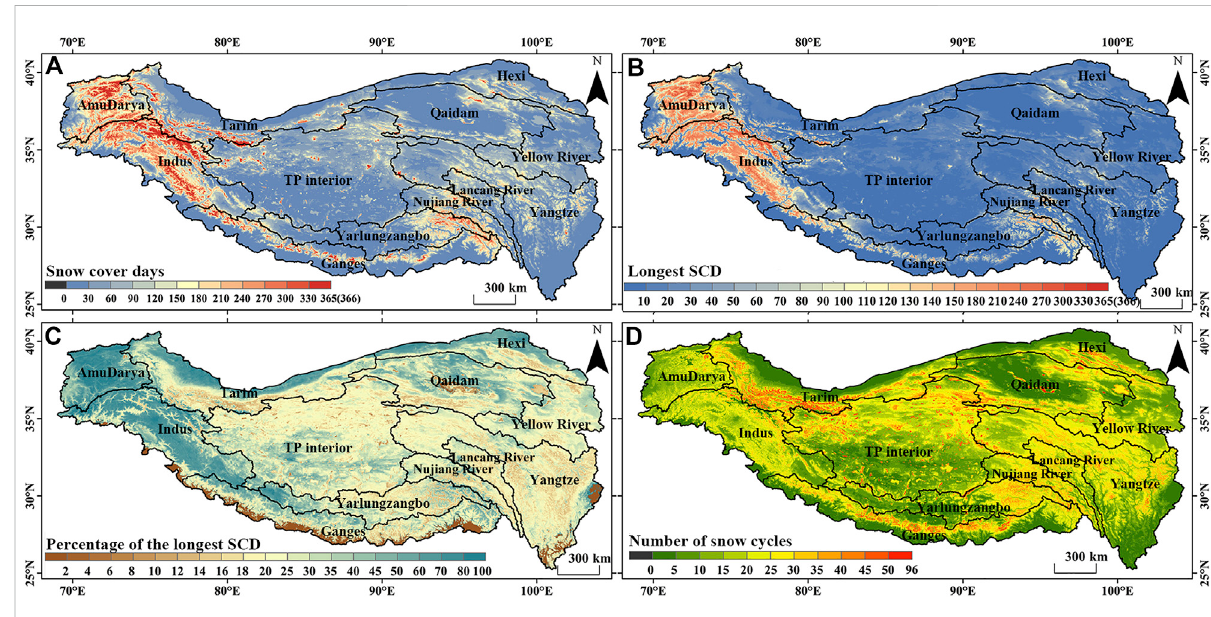
FIGURE 4 TPMFSCDobservedsnowcharacteristicsontheTibetanPlateau. (A) Snowcoverdays, (B) longestsnowcoverduration(SCD), (C) percentageof the longest SCD, and (D) number of snow